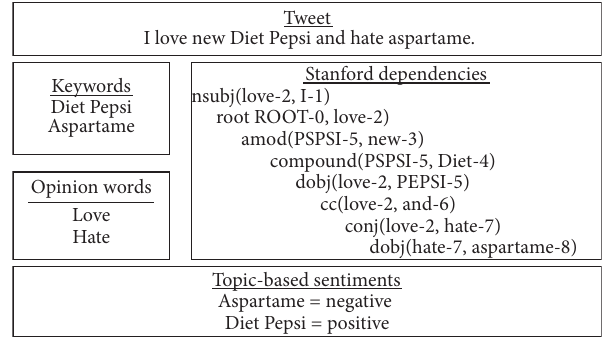
Figure 3: Dependencies from tweet for topic-based sentiment